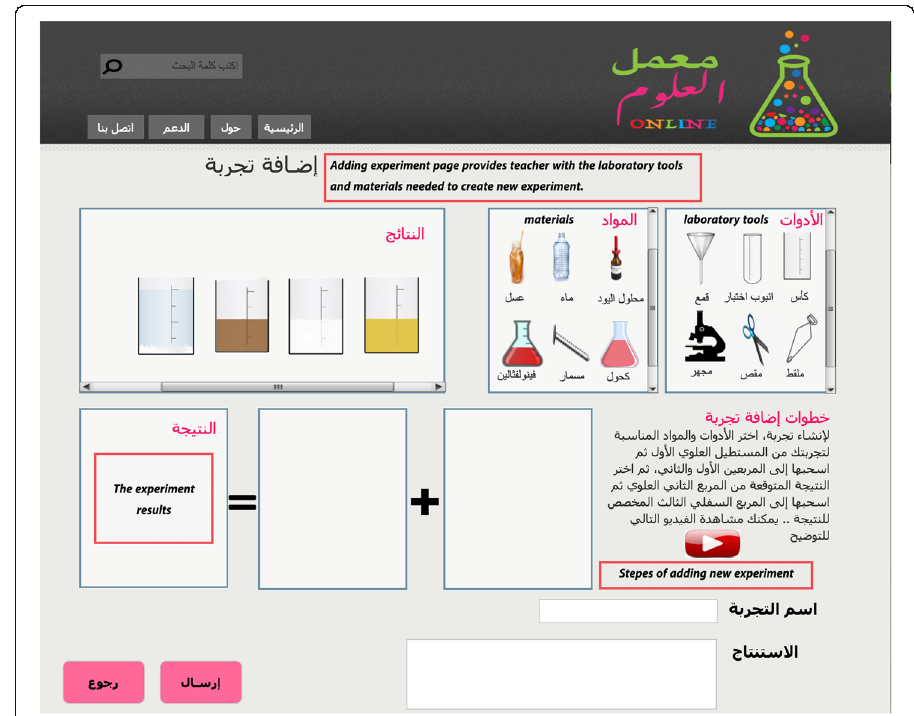
Fig. 7 Screenshot of the add experiment interface on the